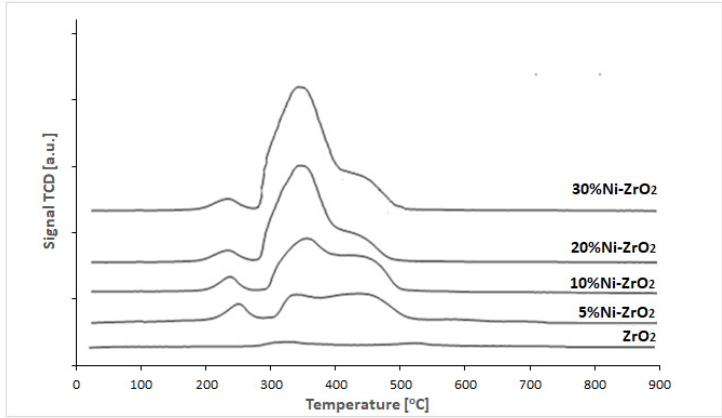
Figure 12. Temperature programmed reduction profiles of ZrO 2 and Ni catalysts supported on ZrO 2 oxide calcined in an air atmosphere for 4h at 400 °C.